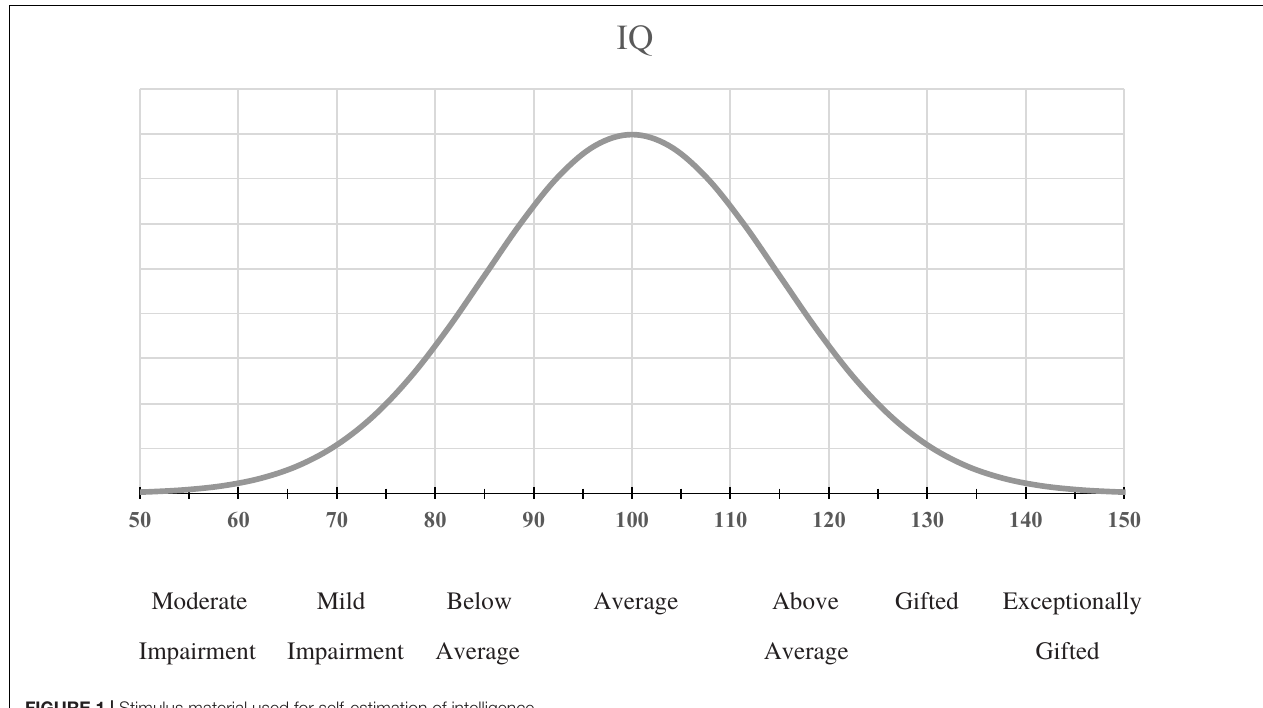
FIGURE 1 | Stimulus material used for self-estimation of